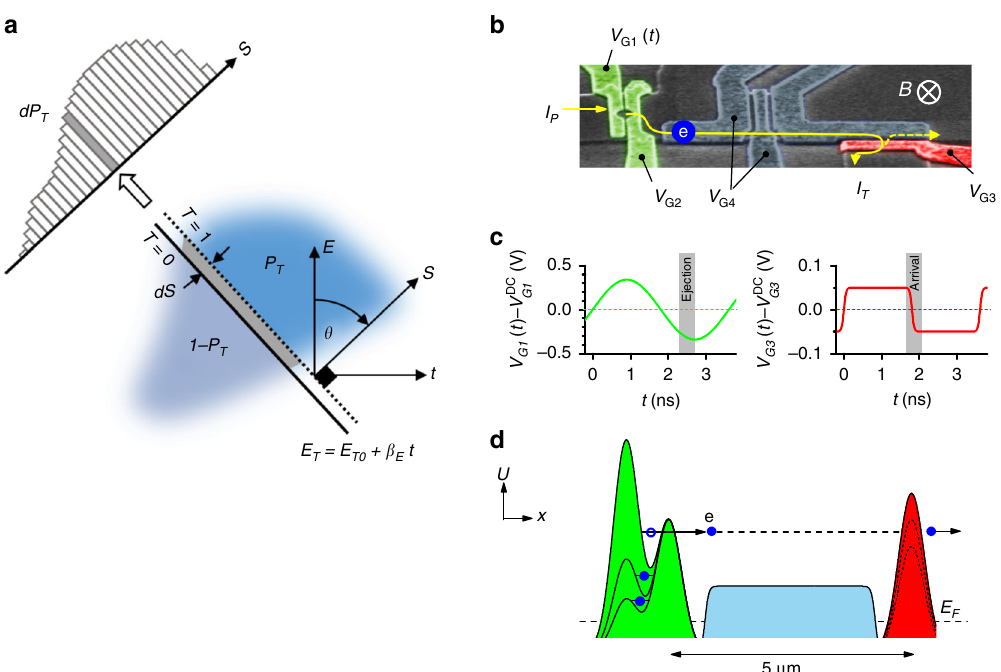
Fig. 1 Electron tomography scheme using a modulated barrier. a An unknown Wigner distribution W ð E ; t Þ of a periodic electron source electron can be fi ltered using a linear-in-time threshold energy barrier set at height E fl ected part, labelled P (cid:2) P T . The transmitted and re T and 1 T result in a proportionate transmitted and re fl ected currents. A marginal projection of this distribution in the energy, time plane can be measured by fi xing the ramp rate of the barrier β E , which sets E T , then moving the threshold boundary along the axis S in increments dS , while measuring the resulting changes in transmitted current. Repeating the experiment at different ramp rates (which sets the angle θ ) gives enough information for a numerical reconstruction of the distribution. b False-colour scanning electron micrograph of device identical to that measured (see methods for details). The electron pump (left, highlighted green) injects pump current I p . The barrier (right, highlighted red) selectively blocks electrons giving transmitted current I T (cid:6) I P . The path between these is indicated with a line. The gates along the path (controlled by V ) depletes the underlying electron gas but do not block the high energy G4 electrons. c Typical time-dependent control voltages for pump V and probe barrier V (each has a DC offset — see methods). d Electron potential U ð x Þ G1 G3 along the electron path between source and probe barrier at three representative stages for pumping (left) and blocking